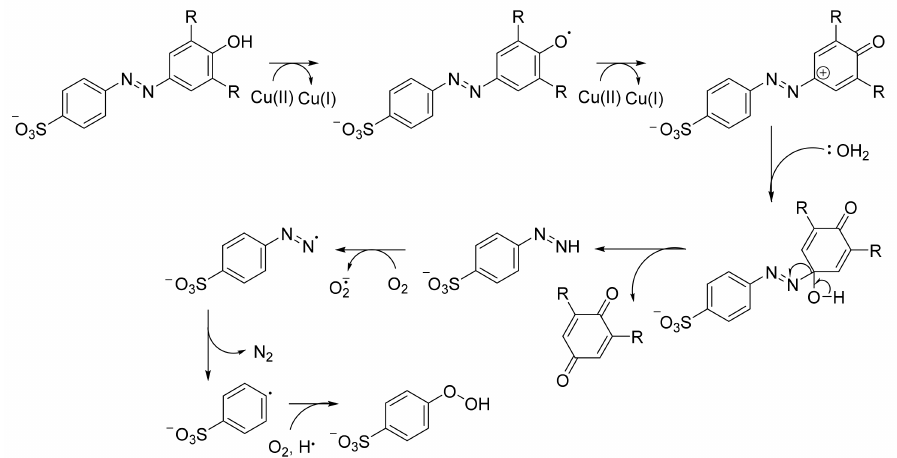
Figure 3. Proposed degradation pathway of azo dyes by laccases. Such activities were proposed for the ascomycete Pyricularia oryzae